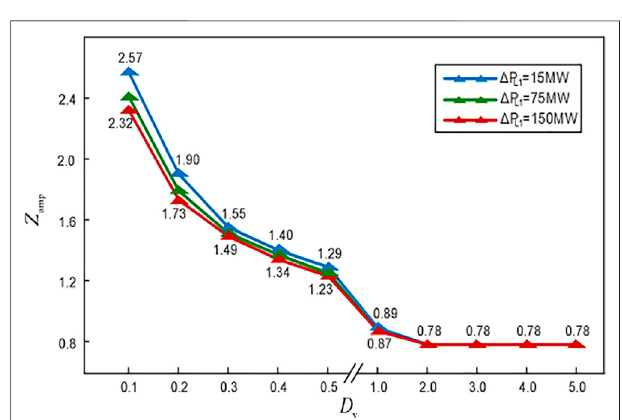
FIGURE 8 | Output of the ESS under different D v .